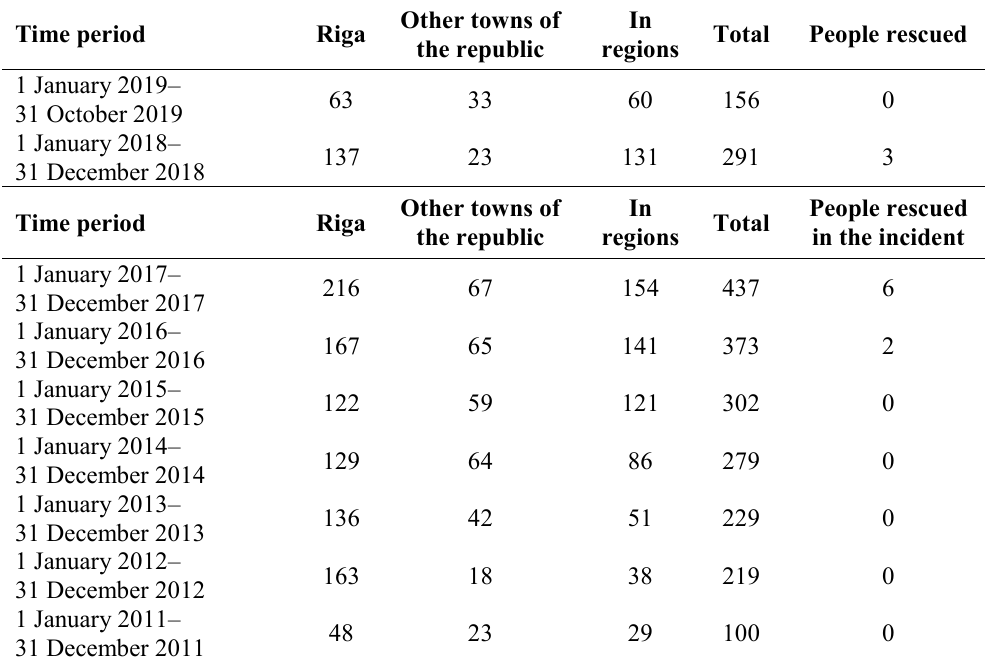
Table 2. State Fire and Rescue Service Reports on the Cases with Dangerous Substances (data processing period is from 1 January 2011 to 31 October